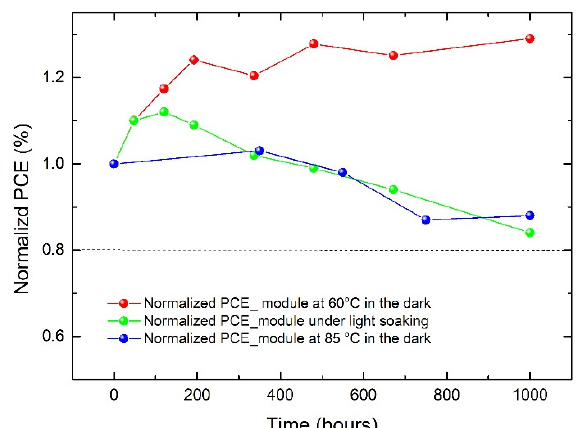
Figure 7. 1000 h test at two different temperatures (60 °C and 85 °C) and under light soaking at environmental temperature.